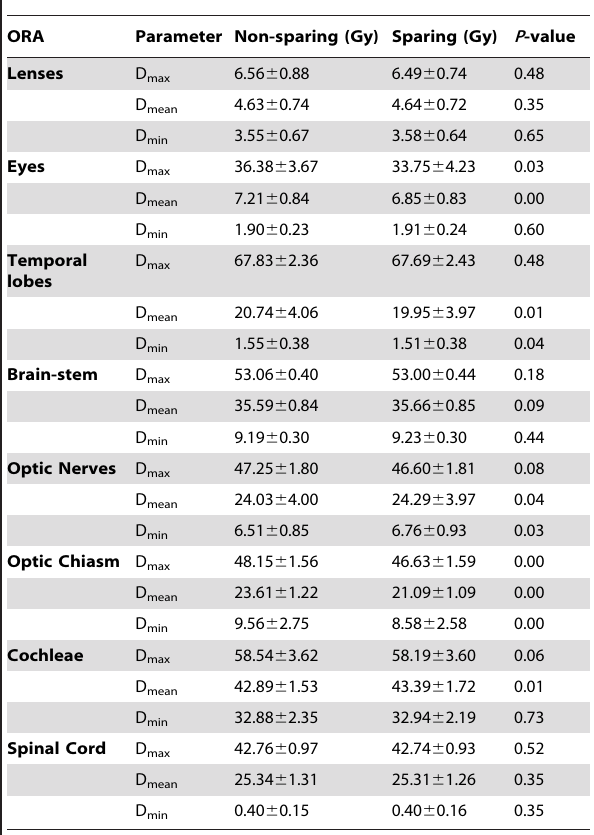
Table 4. D max , D mean and D min of various OARs in IMRT plans with and without HPC sparing.